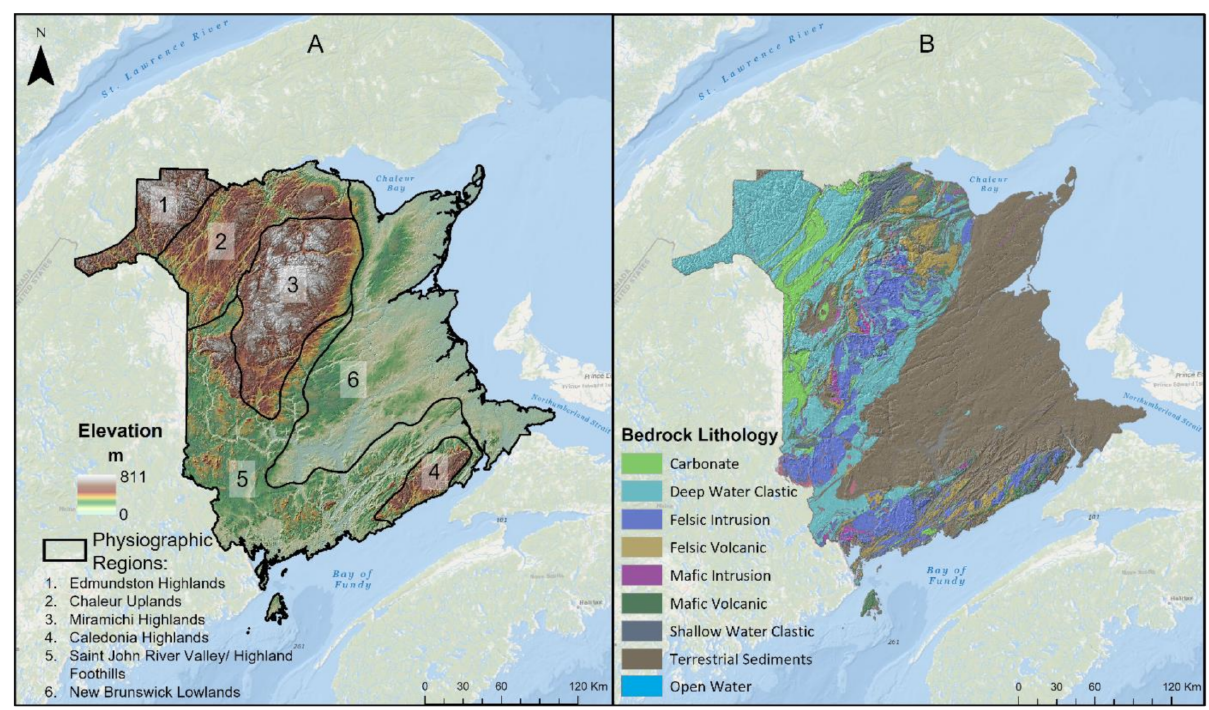
Figure 1. Visualization of the geographic location of New Brunswick, Canada (46.5653 ◦ N, 66.4619 ◦ W) outlining elevation change and physiographic regions ( A ) and an overview of bedrock lithology ( B ), overlain on World Ocean Basemap [30] in ArcGIS 10.3 software [31]. Bedrock geology was acquired from [28] (Scale